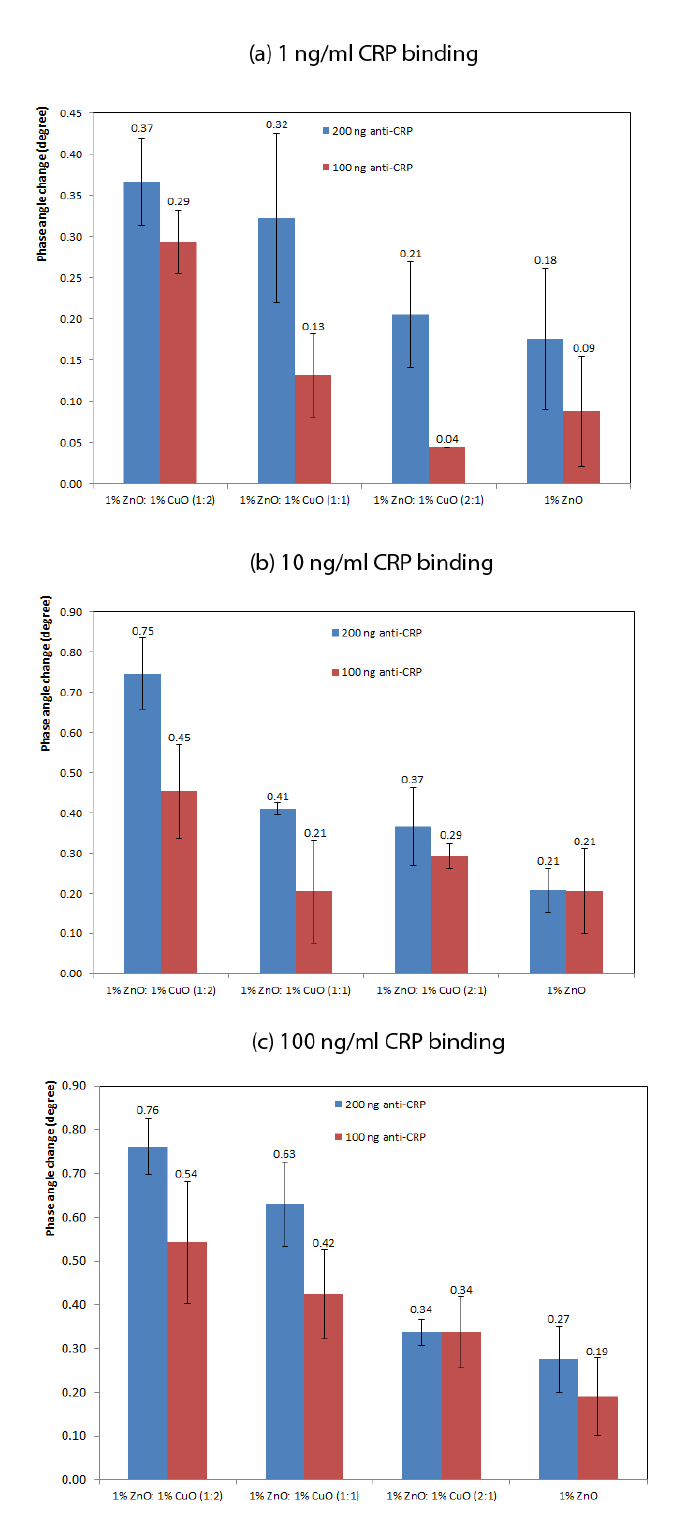
Figure 6. Comparisons of anti-CRP loading (100 ng and 200 ng) on different surfaces at the frequency of 138 Hz ( a ) for the detection of 1 ng/mL CRP (n = 3) with standard error bars; ( b ) for the detection of 10 ng/mL CRP (n = 3) with standard error bars; ( c ) for the detection of 100 ng/mL CRP (n = 3) with standard error